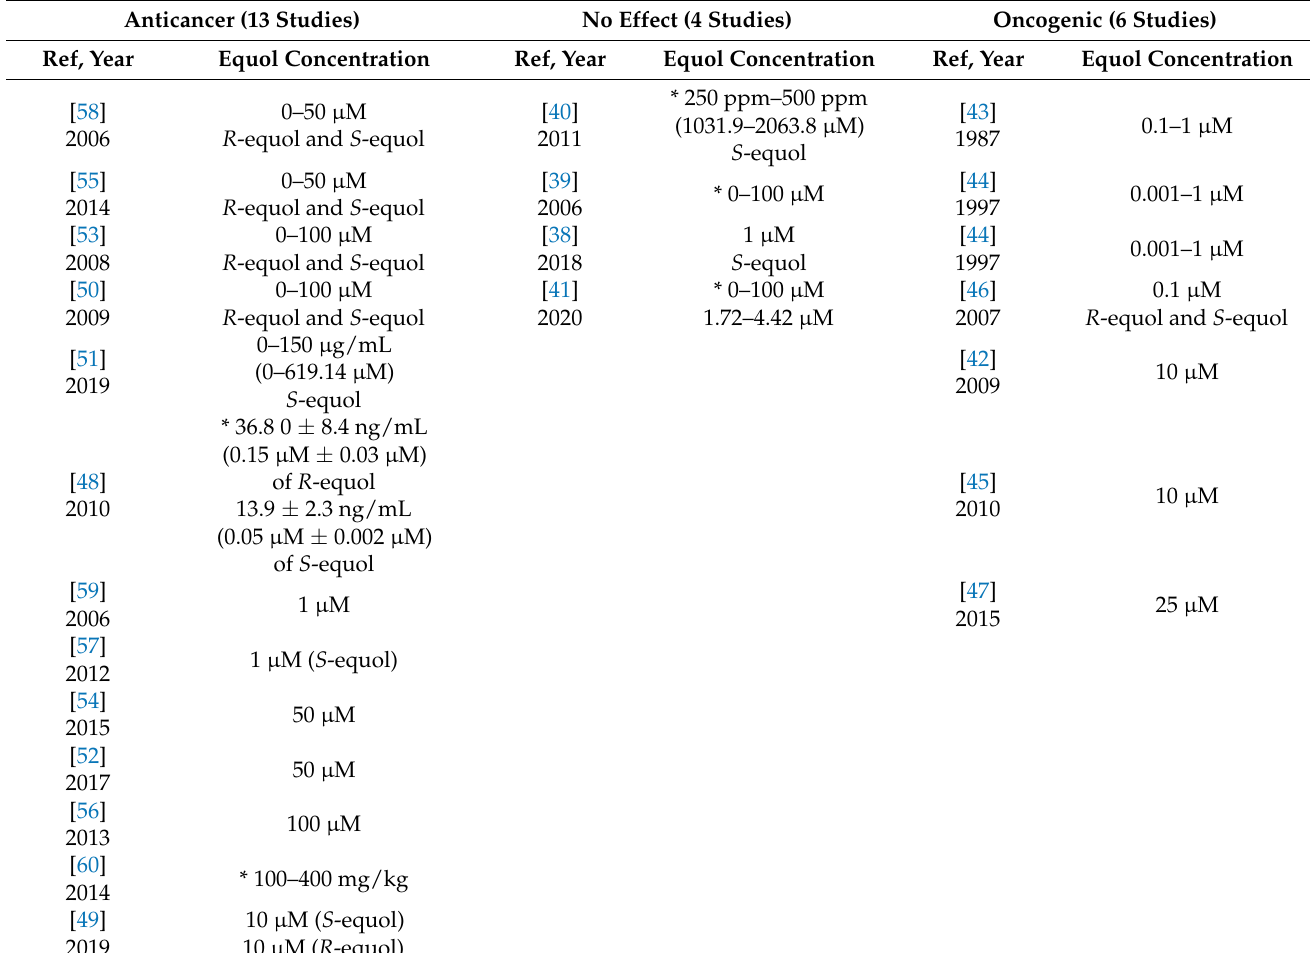
Table 1. Comparison of equol concentrations used in in vitro and in vivo